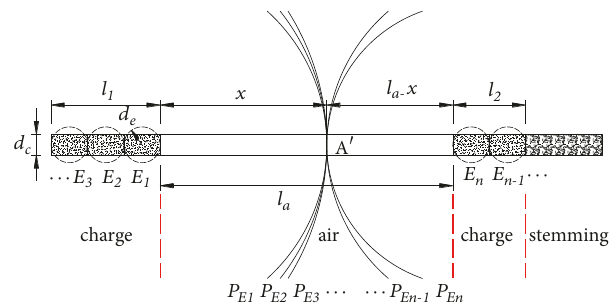
Figure 3: Initial shock pressure of borehole wall with middle air- decked charge.